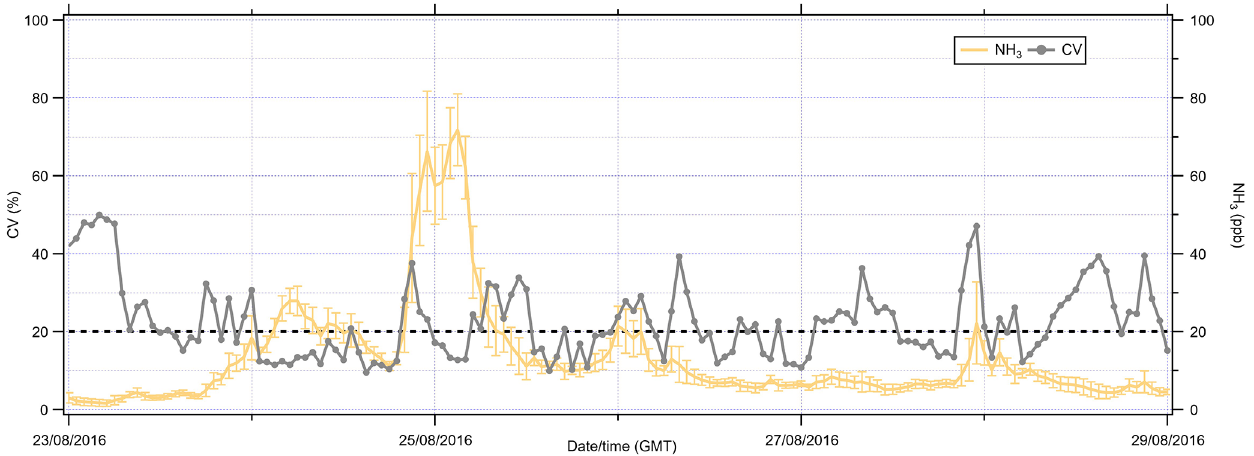
Figure 6. Time series hourly coefficient of variance (CV) and the average reported NH 3 concentration (ppb), where error bars are ± σ A . The black dotted line is a CV limit of